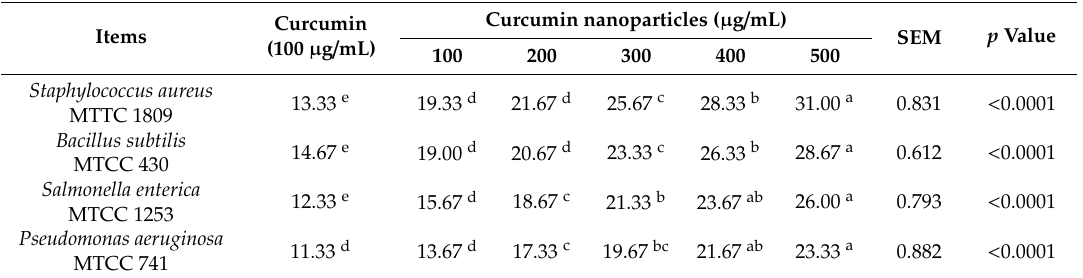
Table 1. Zone of inhibition produced by curcumin and curcumin nanoparticles.